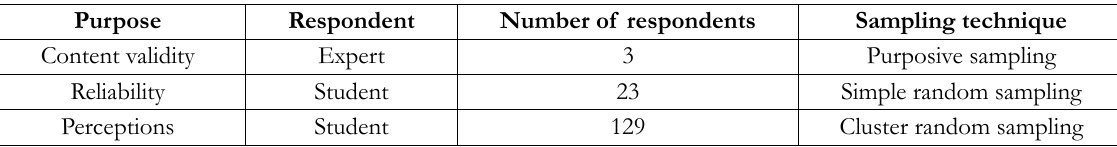
Table 3. Demographic information of respondents in the study (Hamid, 2020)